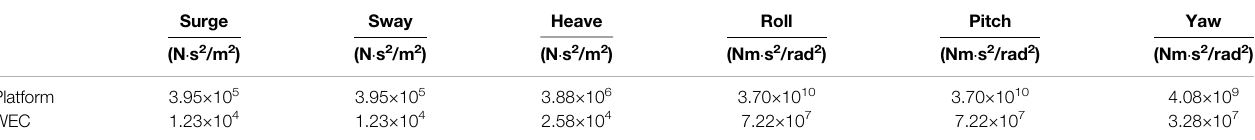
TABLE 2 | Quadratic drag coef fi cients C ii for the semi-submersible platform and WECs (Robertson et al., 2014).